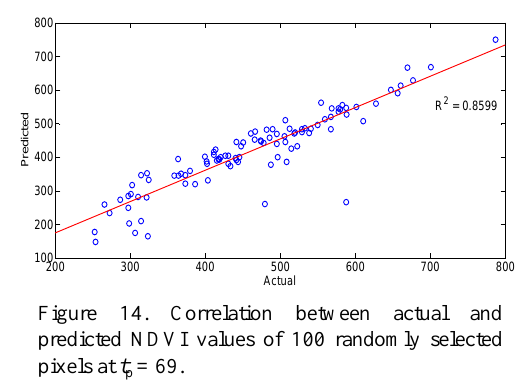
Figure 9. Comparison of actual NDVI images with predicted results at fine spatial resolution. (a) Actual NDVIs at times t p . (b) Predicted NDVI